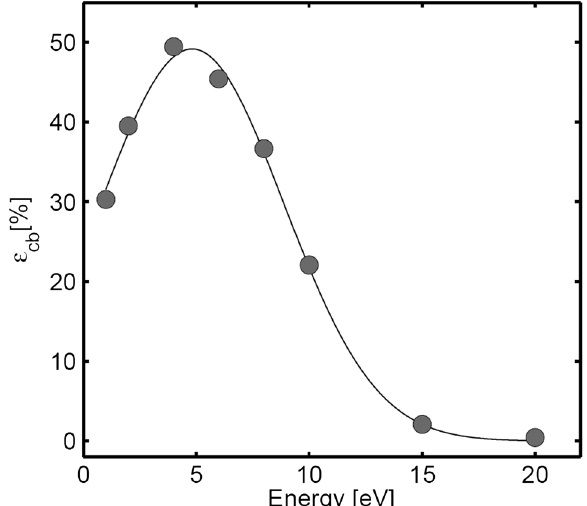
FIG. 3. 85 Rb 1 þ ions capture as a function of the injection energy inside the charge breeder for different values of the injected beam rms transverse emittance. The reference curve 2 π mm mrad. A Gaussian fit is super- corresponds to ϵ rms ¼ imposed to each numerical curve.